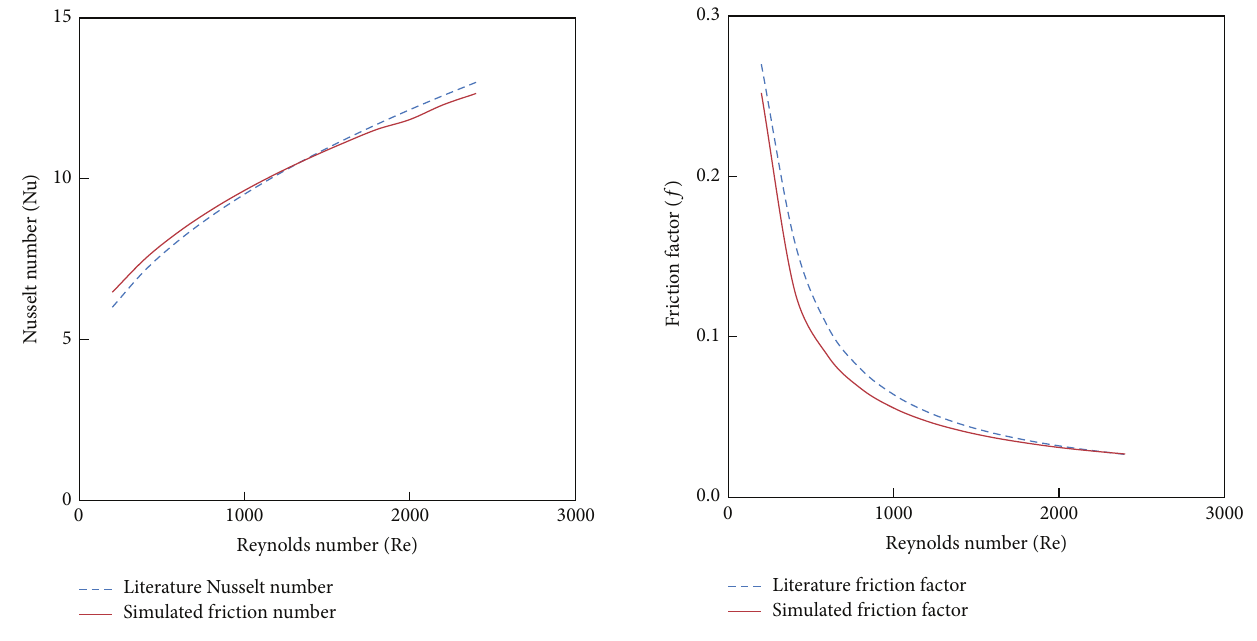
Figure 3: Plain tube simulated Nusselt number versus literature value.